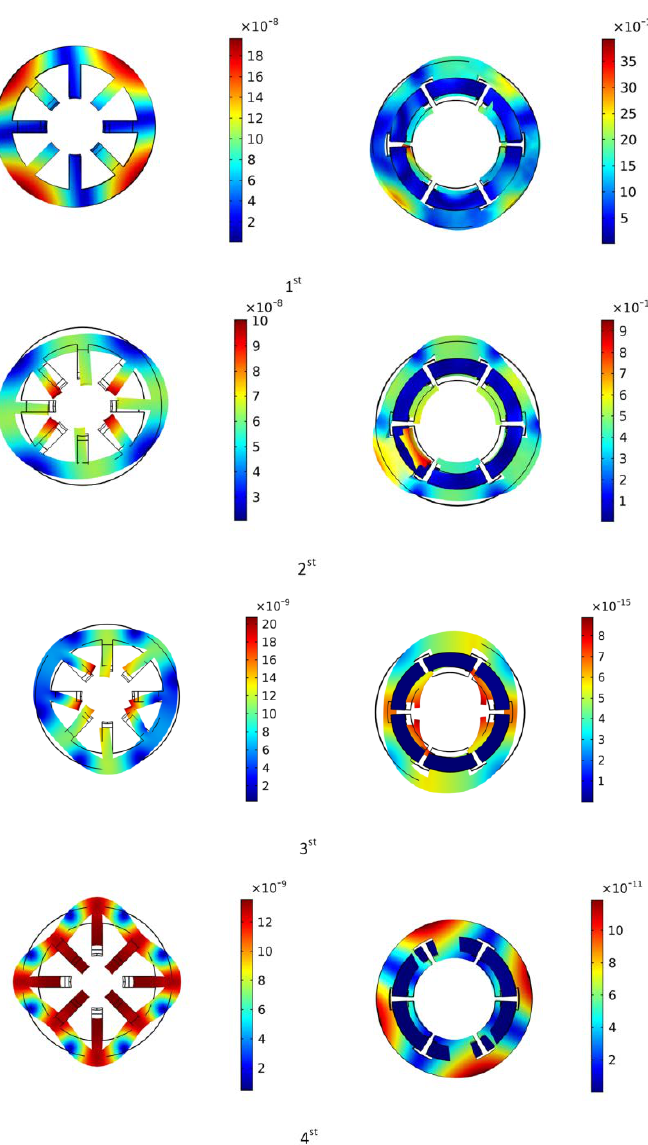
Figure 9. Modal comparison (unit: m).